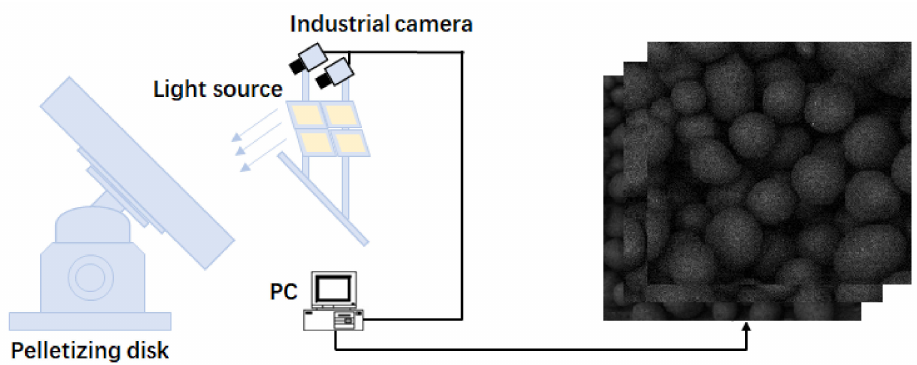
Figure 1. Schematic diagram of pellet image acquisition for pellet-making